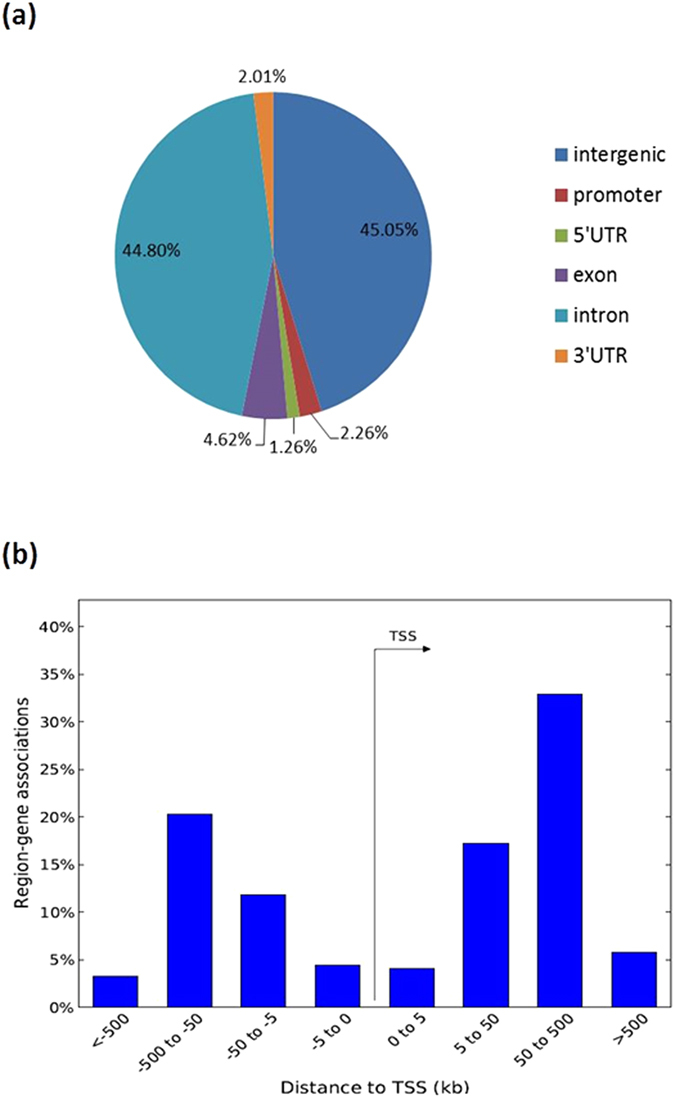
Distribution of HIF-2α ChIP-seq peaks in BEAS-2B under normoxia.(a) Pie chart illustrating the genomic locations of HIF-2α binding sites. (b) Bar graph showing the percentage of region–gene associations according to genomic regions’ distance to TSS computed by Genomic Regions Enrichment of Annotations Tool (GREAT) (http://bejerano.stanford.edu/great/public/html/).